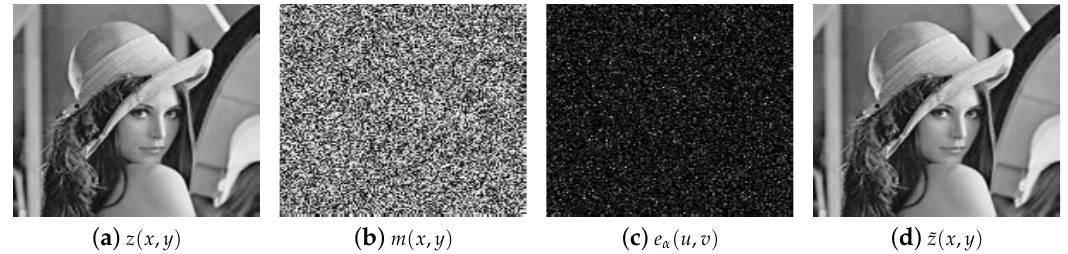
Figure 2. ( a ) Original image to encrypt z ( x , y ) . ( b ) Random distribution code m ( x , y ) of the random phase mask (RPM) k ( x , y ) . ( c ) Encrypted image e α ( u , v ) for the security keys α = 0.727 π and the RPM h ( x , y ) . ( d ) Right decrypted image ˜ z ( x , y )